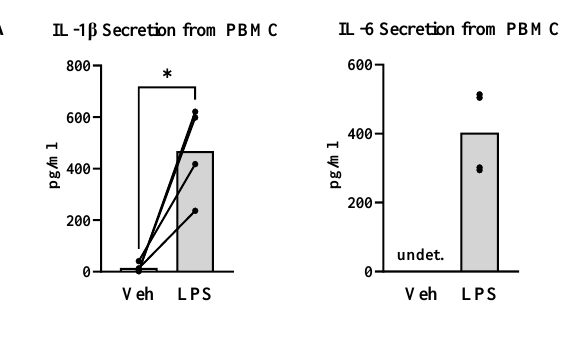
Figure 3. ( A ) Inflammatory cytokine secretion from LPS-stimulated PBMC ( n = 4). ( B , C ) The comparison of the effects of dipeptides and amino acids (each at 100 µM) on inflammatory cytokine secretion by PBMC ( n = 3-4). The lined plots are the data from the same subjects. Data are shown as means. Data were analyzed by ( A ) repeated t-test or ( B , C ) repeated one-way ANOVA followed by Tukey’s post-hoc test [* p < 0.05]. Hyp-Gly and Pro-Hyp refer to dipeptides. Hyp + Gly means a mixture of Hyp and Gly. Pro + Hyp means a mixture of Pro and Hyp.